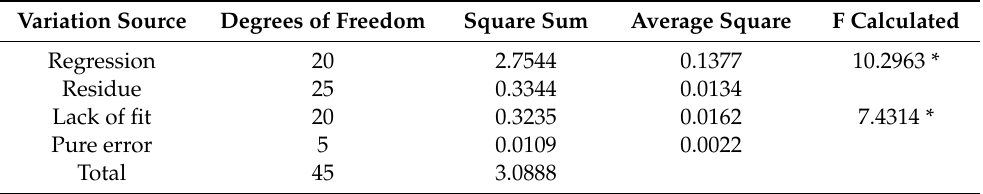
Table 5. Analysis of variance from the complete model of regression for the efficiency of the SMX degradation treated by the Fenton-like process.